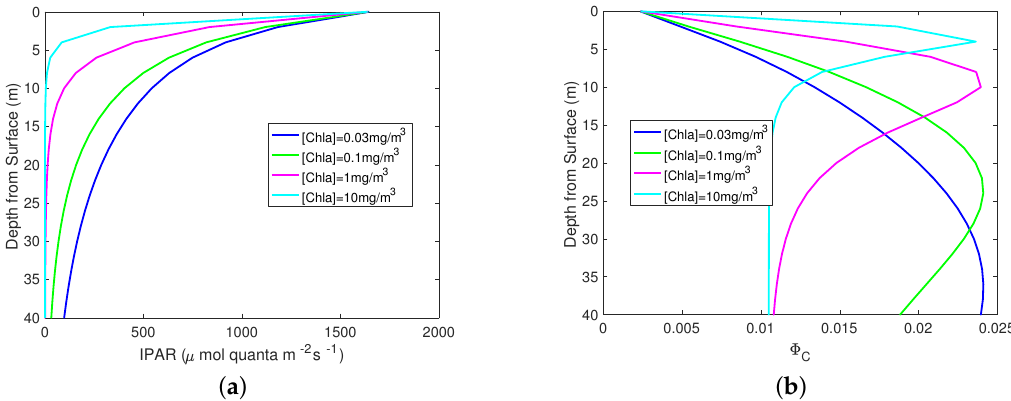
Figure 1. ( a ) IPAR and ( b ) quantum yield as a function of depth for a set of [Chla]. The aerosol optical depth at 550 nm is 0.1 and the solar zenith angle is 30 ◦ .